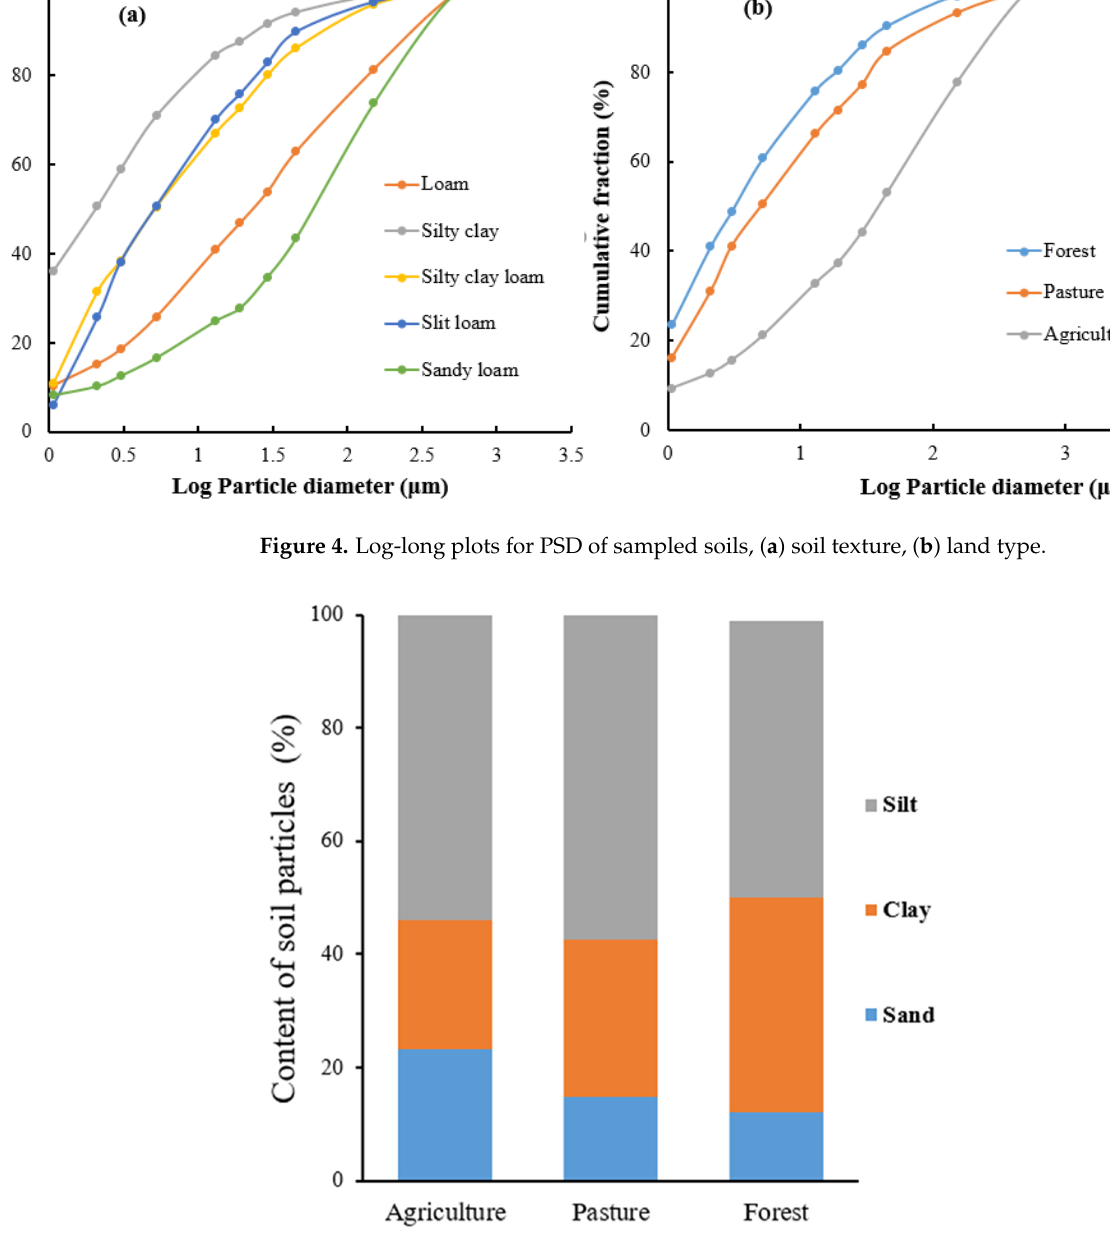
Figure 5. Soil particles in different land uses.